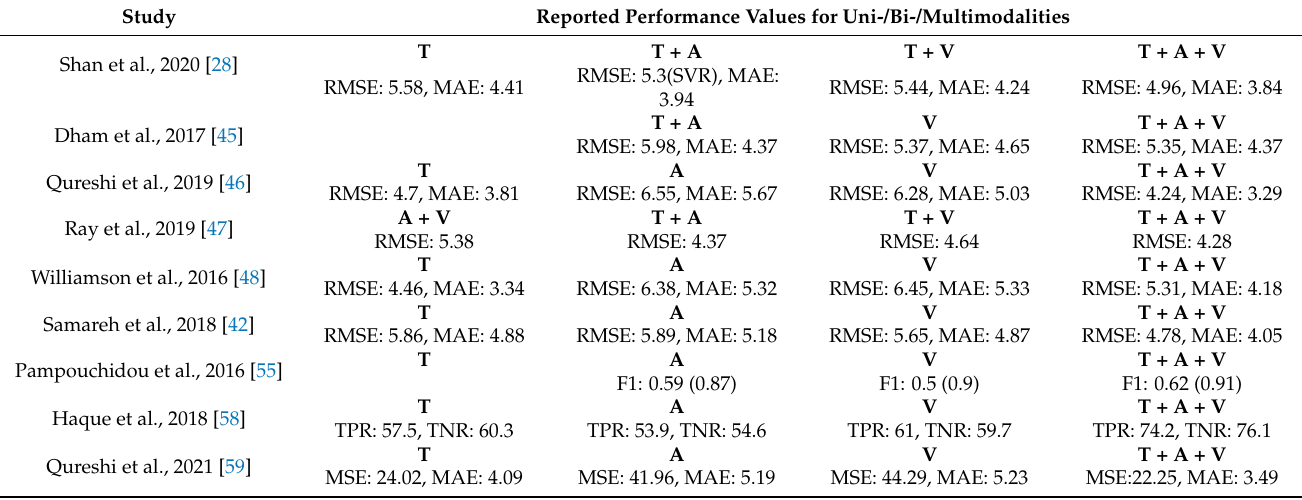
Table 9. Comparison table for the reported performance values for all modalities (T: text; A: audio; V: